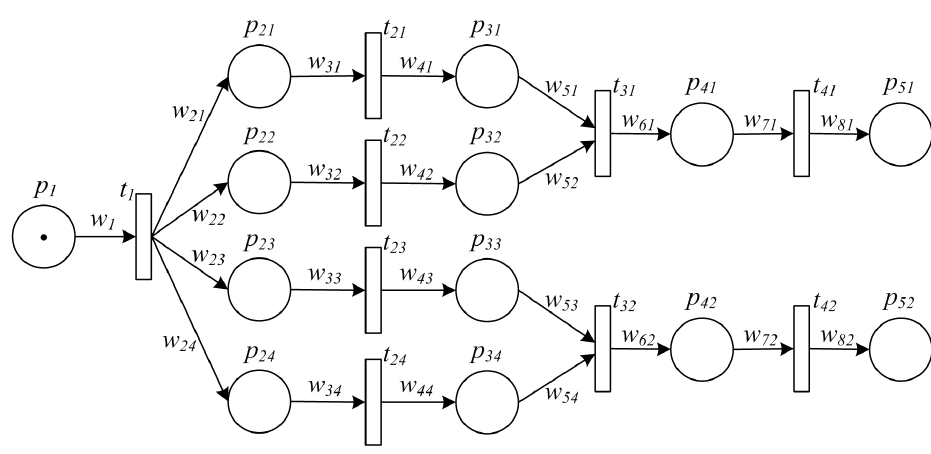
Figure 1. An example of PPN model for a typical manufacturing